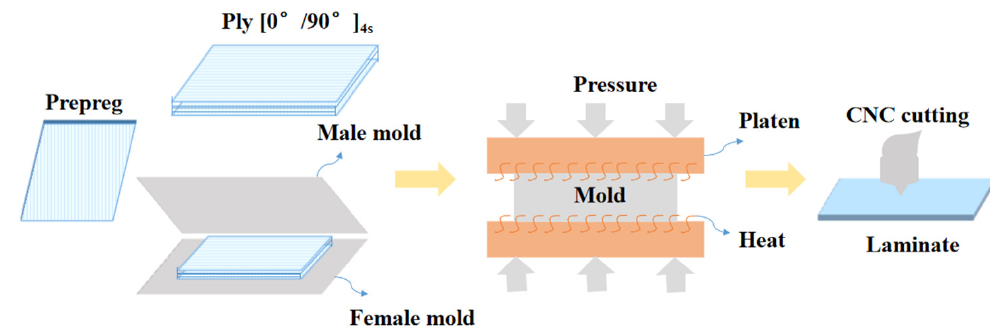
Figure 1. Fabrication of single-lap laminate.